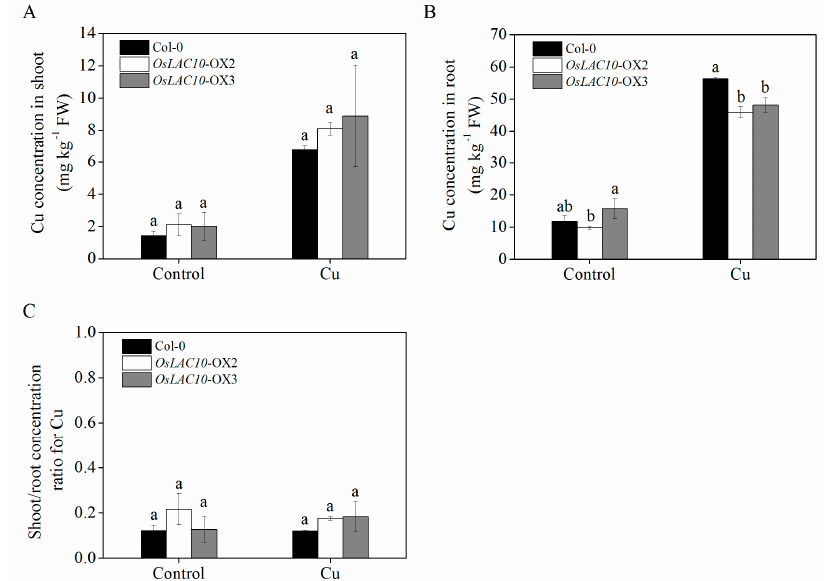
Figure 9. Cu concentration in shoots and roots of wild-type and OsLAC10 transgenic Arabidopsis exposed to 5 μ M Cu under hydroponic conditions. ( A ) Cu concentration in shoots; ( B ) Cu concentrations in root; ( C ) Cu transfer coefficient (S/R). The data are the means ± SD ( n = 3). Different letters (a, b) above the column indicate a significant difference at p < 0.05 according to the LSD tests.